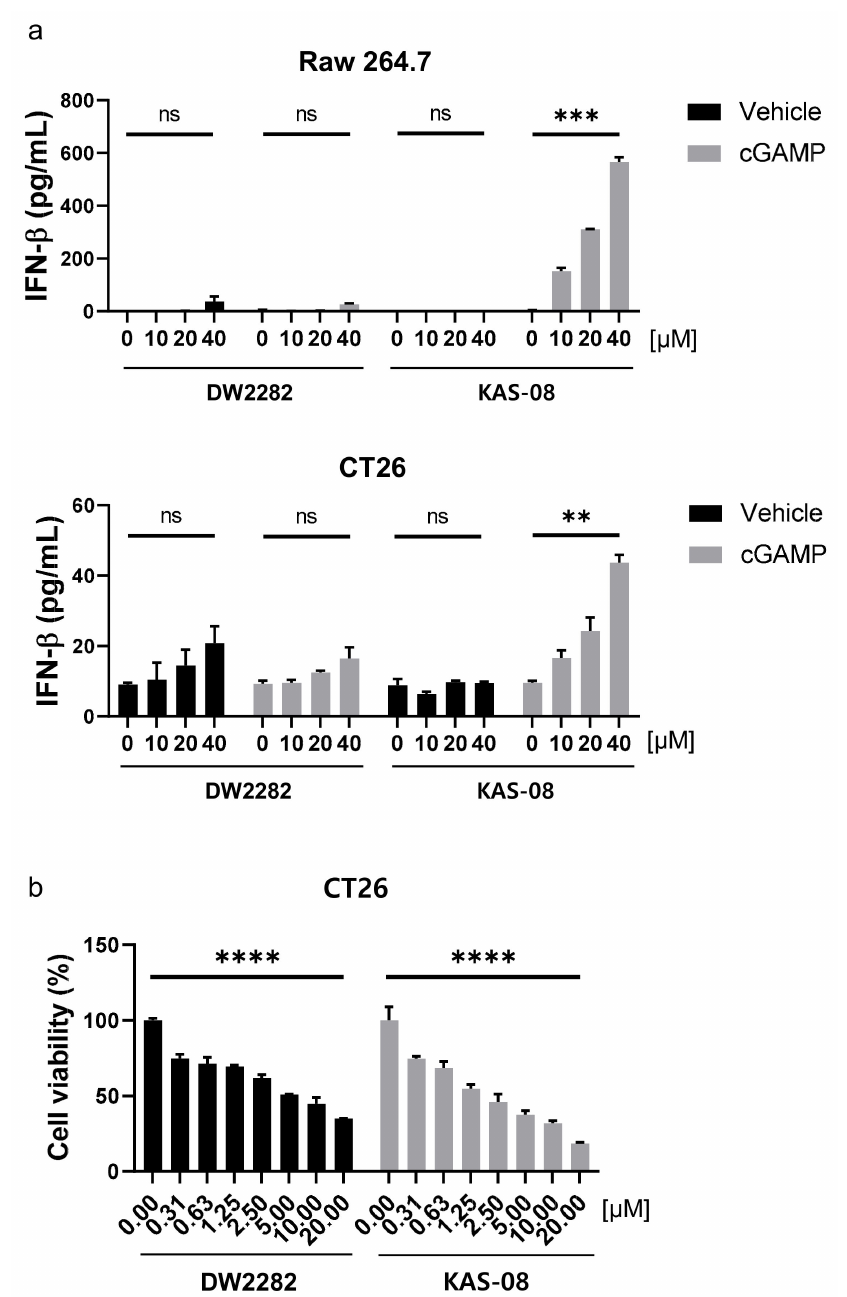
Figure 6. KAS-08 enhanced the cGAMP-mediated STING activation in mouse cells. ( a ) ELISA analysis of IFN β secretion by DW2282 and KAS-08 treatment in the absence or presence of cGAMP (1 µ g/mL) in Raw264.7 ( up ) and CT26 ( down ) cells. ( b ) Cell viability of DW2282 and KAS-08 after 72 h treatment in CT26 cells. Graphs show mean and SD. **: p < 0.01, ***: p < 0.001, ****: p < 0.0001 and ns: non-significant by Student’s t